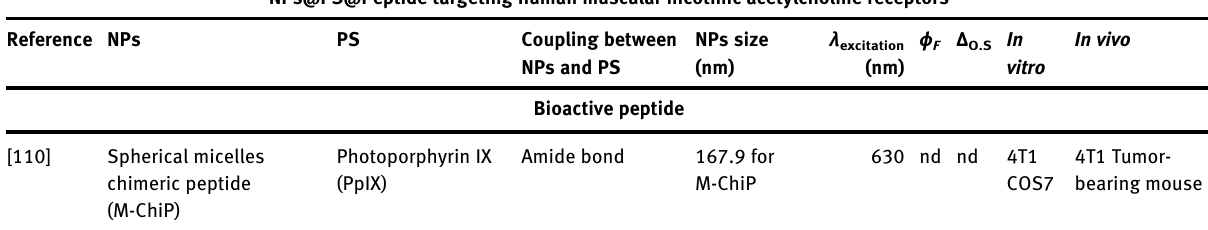
Table  : The summary of NPs conjugated with PSs and peptides targeting human muscular nicotinic acetylcholine receptors in terms of different